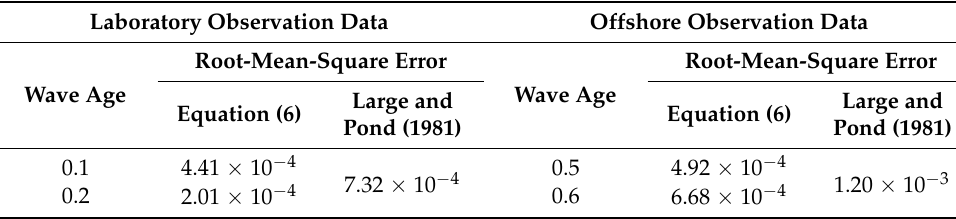
Table 1. Error between calculated results and observed data with different wave